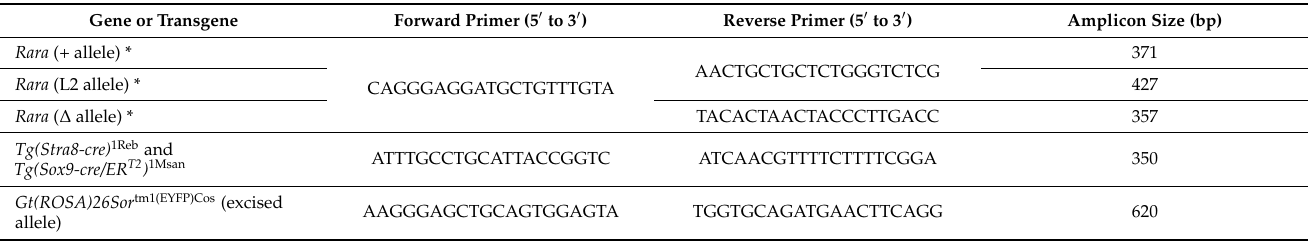
Table 1. Sequences of the primers used for genotyping